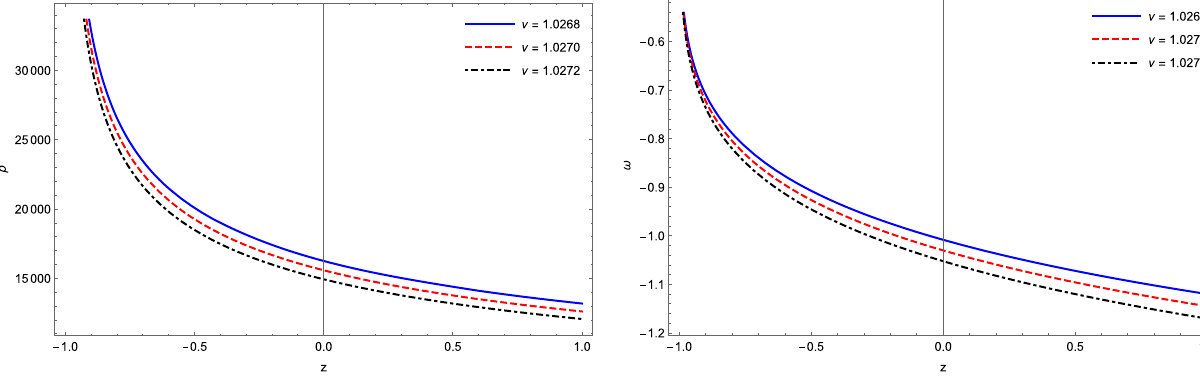
Fig. 3 Effective energy density (left panel) and EoS parameter (right panel) in redshift. The parameter scheme: α = 0 . 21 ,λ = 315 ,γ = 2 Table 1 We illustrate the present value of Hubble parameter, H ( z 0 ) ; deceleration parameter, q ( z 0 ) ; and EoS parameter; ω( z 0 ) for three different parameter values of ν for both the examples Parameter First example: f ( T ) = T + β T 2 Second example: f ( T ) =